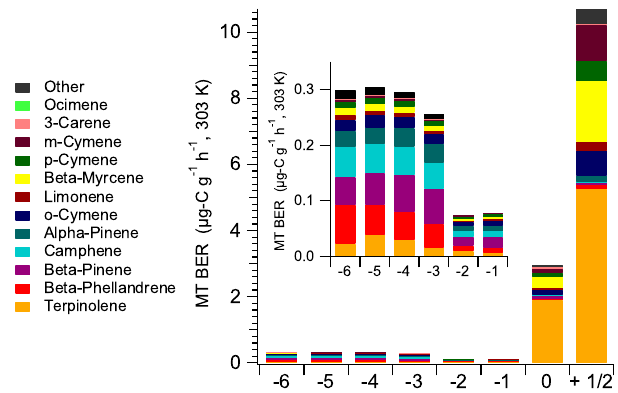
Figure 6. Emission profile of emissions from Thuja plicata during methyl jasmonate (MeJA) experiment TP-E. The x axis denotes the day relative to treatment application. The y axis shows the monoter- penoid BER normalized to 303 K. Note the drastic scale change between the pre- and post-treatment y axes. The insert shows an en- larged view of the first 6 days to allow better visualization of the pre-treatment period. Table 5. Results of linear regression correlation analysis ( r 2 ) be- tween all monoterpenoid emission rates (ERs) vs. terpinolene emis- sion rates and limonene emission rates during experiment